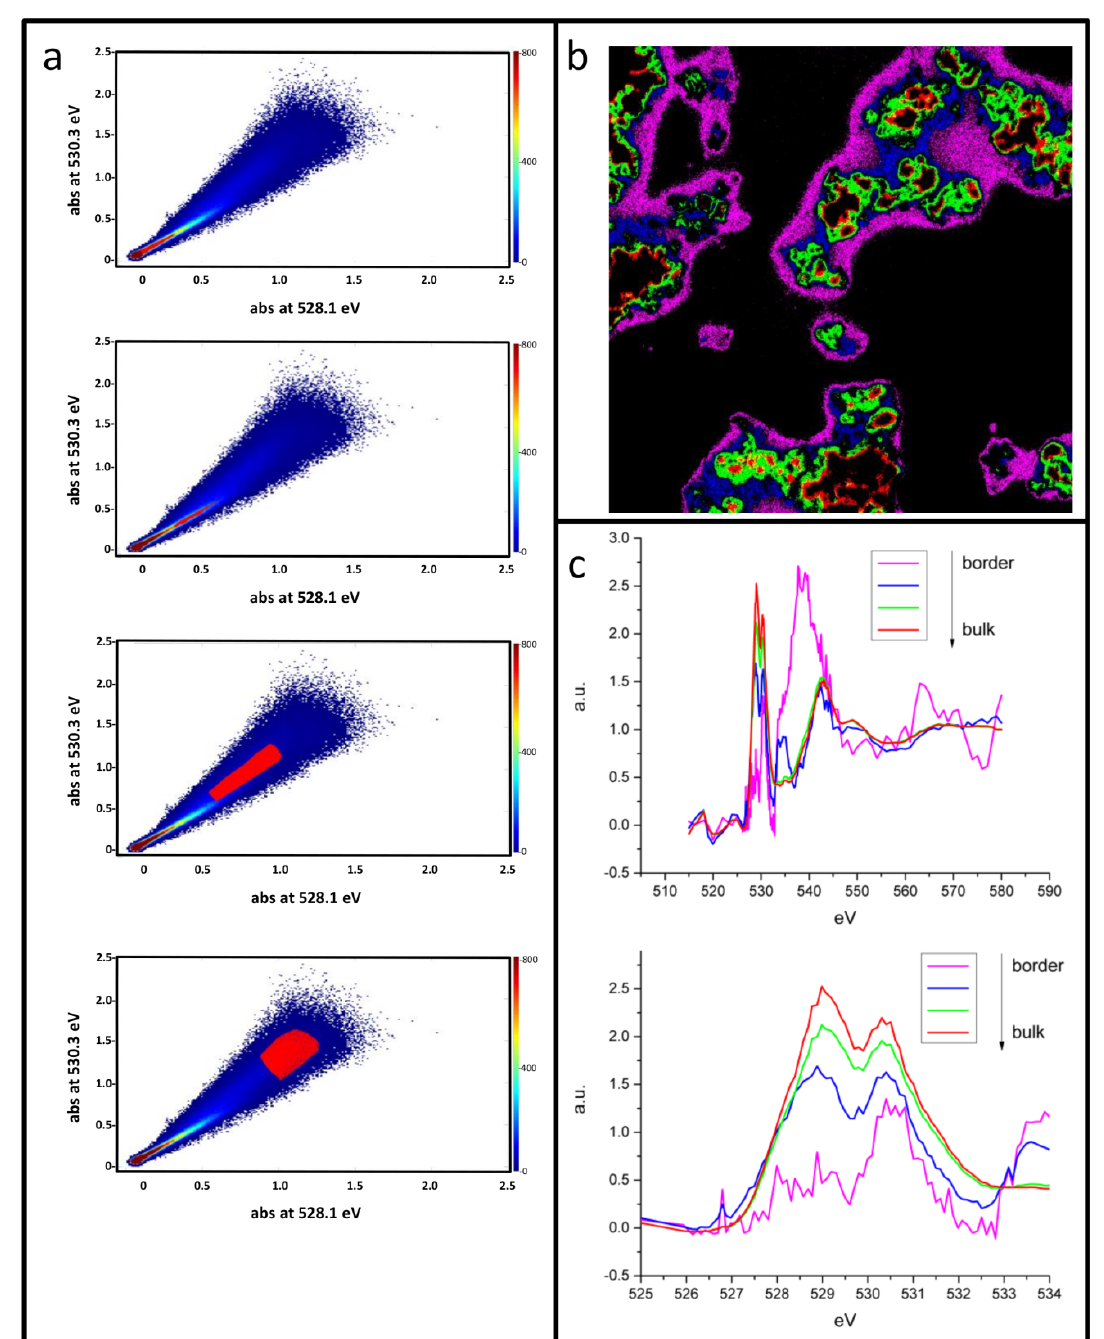
Figure 9. Same as Figure 7 on the fully charged VOx-coated Li 1.2 Mn 0.56 Ni 0.16 Co 0.08 O 2 electrode material (P05VC).